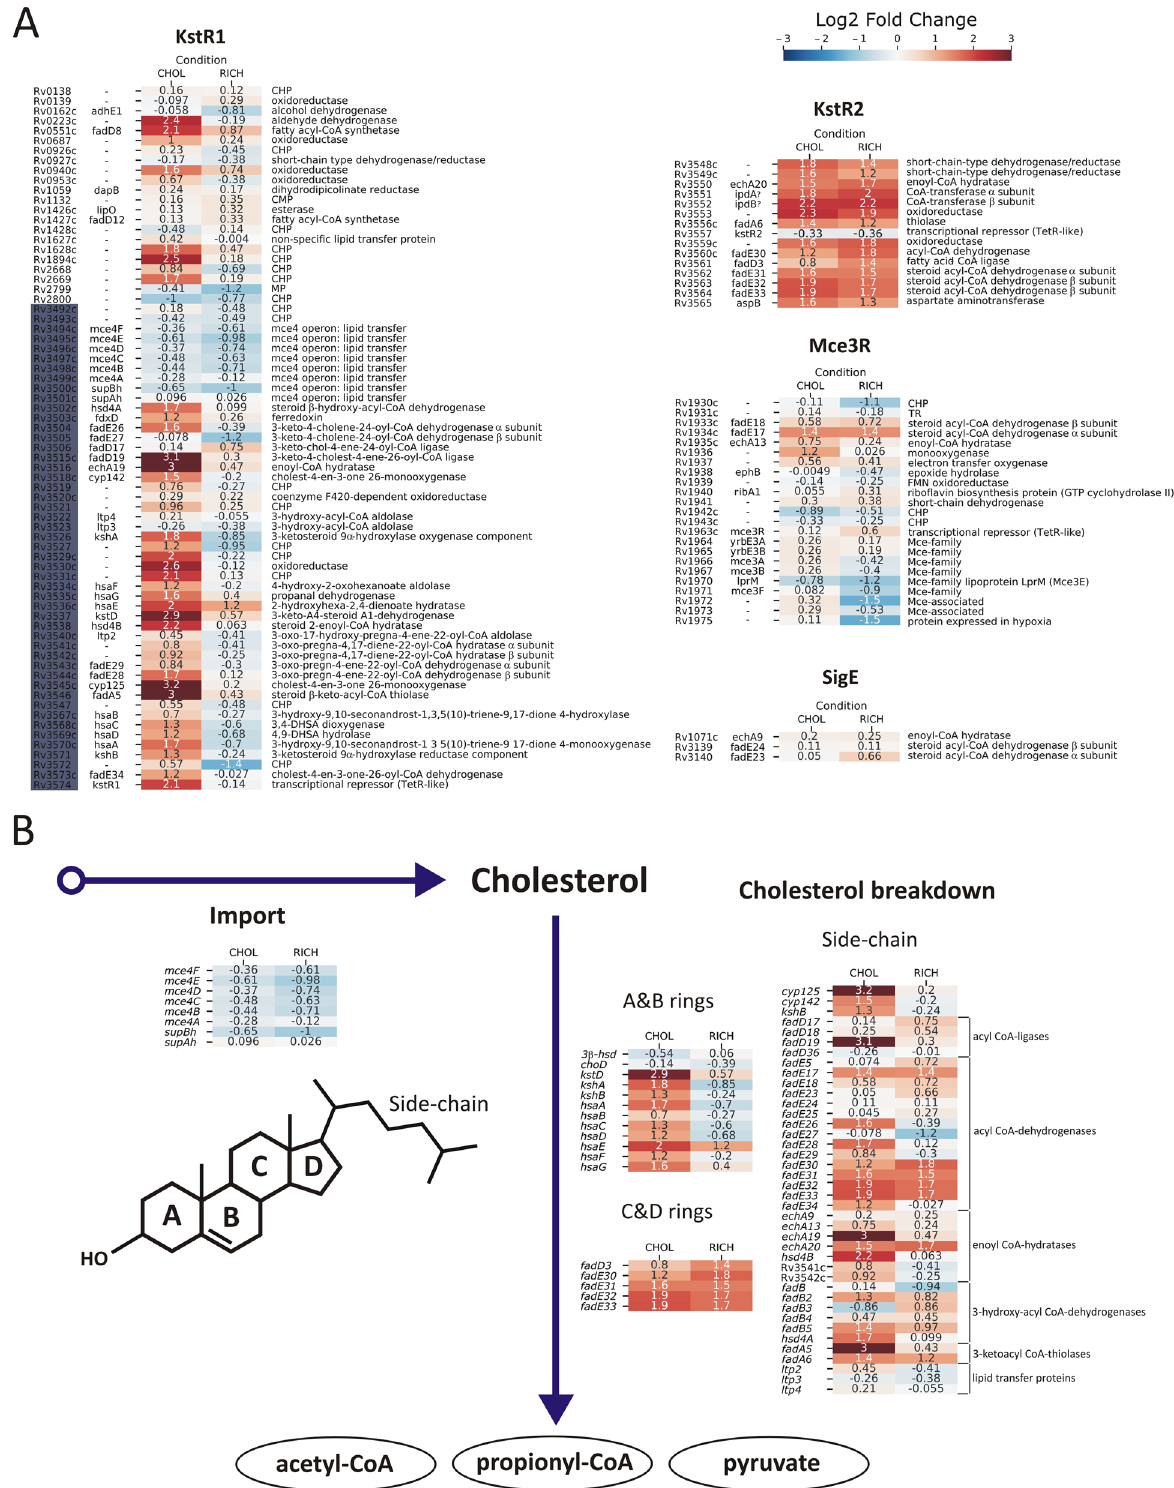
Figure 2. Differential gene expression of cholesterol import and breakdown genes. DGE analysis was performed comparing conditions of Mtb grown in glycerol vs cholesterol (CHOL) or glycerol vs 7H9/10% OADC medium (RICH). The results are presented as a heatmap of the log2-fold change in expression. See the color key for log2FC values. ( A ) Gene expression within KstR1, KstR2, MceR, and SigE regulon genes that were previously assigned as cholesterol-induced/associated. Genes that belong to the Cho-region 9 are marked dark blue ( B ) DGE analysis of a functional compilation of genes that were previously classified in various studies 28 as induced by cholesterol and involved in cholesterol import and